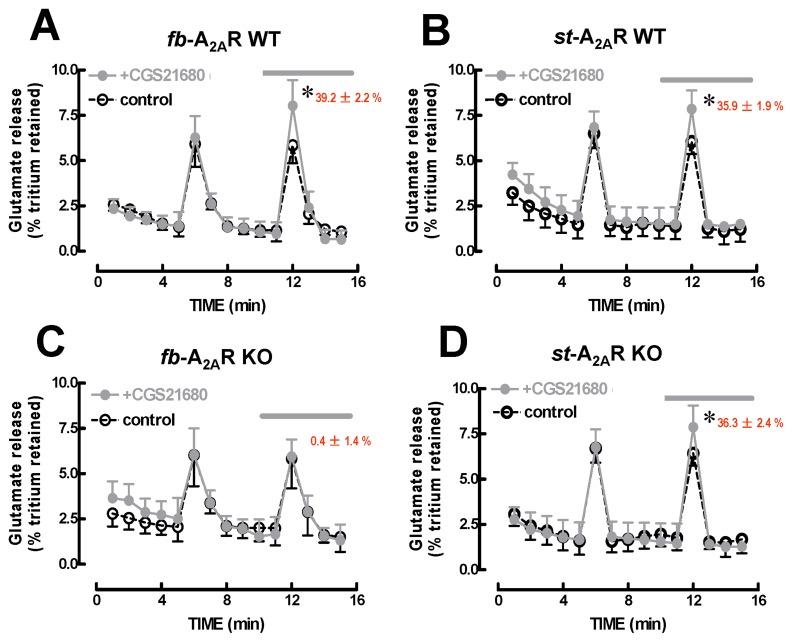
A2AR-mediated facilitation of 3H-glutamate release from striatal synaptosomes is abolished in forebrain-A2AR KO but preserved in striatum-A2AR KO mice.The A2AR selective agonist, CGS21680 (20 nM) facilitated the evoked 3H-glutamate release from striatal synaptosomes of fb-A2AR WT (n = 6, A), st-A2AR WT (n = 8, B) and st-A2AR KO (n = 4, D) but not fb-A2AR KO (n = 4, C). Each graph depicts the time course of tritium release enhanced by 20 mM K+ (evoked release, applied twice) in the absence (black symbols and lines) or presence of 20 nM CGS21680 (grey symbols and lines), as indicated by the horizontal lines. Indicates a significant (p<0.05, using a one-sample t-test against the hypothetical value of 0%) CGS21680-induced facilitation and the mean ± SEM facilitation is also indicated.